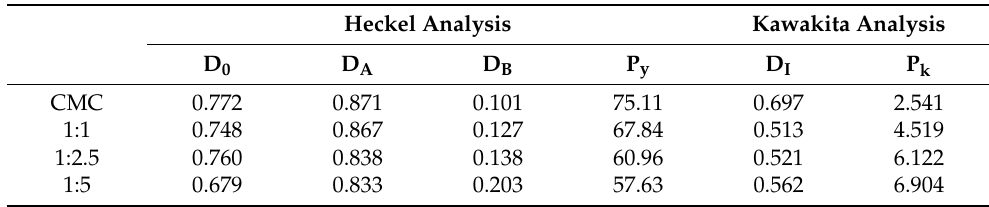
Table 5. Parameters involved in Heckel and Kawakita analysis for tablet constituting CMC-SiO